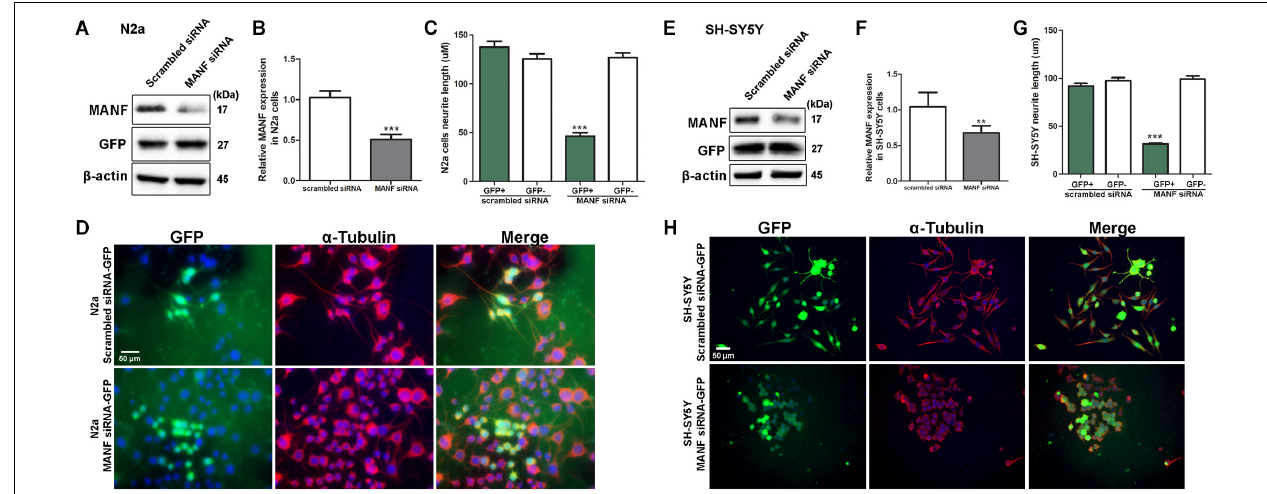
FIGURE 3 | MANF knockdown by siRNA inhibits RA-induced neurite outgrowth. N2a and SH-SY5Y cells were transfected with MANF siRNA-GFP or scramble siRNA-GFP construct as described in the section “Materials and Methods.” (A,E) 24 h after the transfection, cells were lysed and analyzed by immunoblotting with MANF and GFP antibodies. β -actin was used as a loading control. The size of the proteins (kDa) was labeled next to each band. (B,F) MANF protein levels were quantified and normalized to β -actin. The data were analyzed by Student’s t test, *** P < 0.0001. The data were expressed as the mean ± SEM of three independent experiments. (C,G) Average neurite length in scramble siRNA and MANF siRNA transfected GFP+ cells after 3 days of RA treatment was determined and analyzed by Student’s t test, *** P < 0.0001. The data were expressed as the mean ± SEM of three independent experiments. (D,H) Representative fluorescent images revealed GFP expression in cells with successful siRNA transfection (Green). Neurites were visualized by immunofluorescent labeling of α -tubulin (Red). Cell nuclei were stained by DAPI. ** P < 0.01.